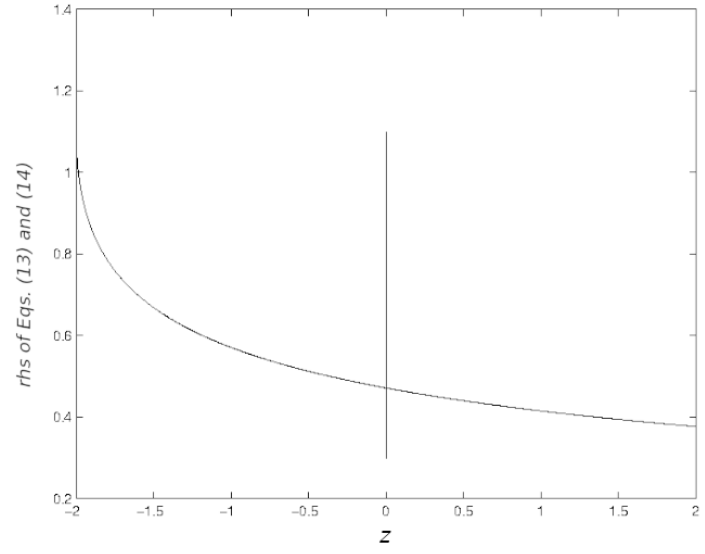
Figure 2. Plot of the right-hand side of Equations (13) and (14) for z ∈ [ − 2,2 ] . The plot of nega- tive values of z corresponds to Equation (14) and the plot of positive values of z corresponds to Equation